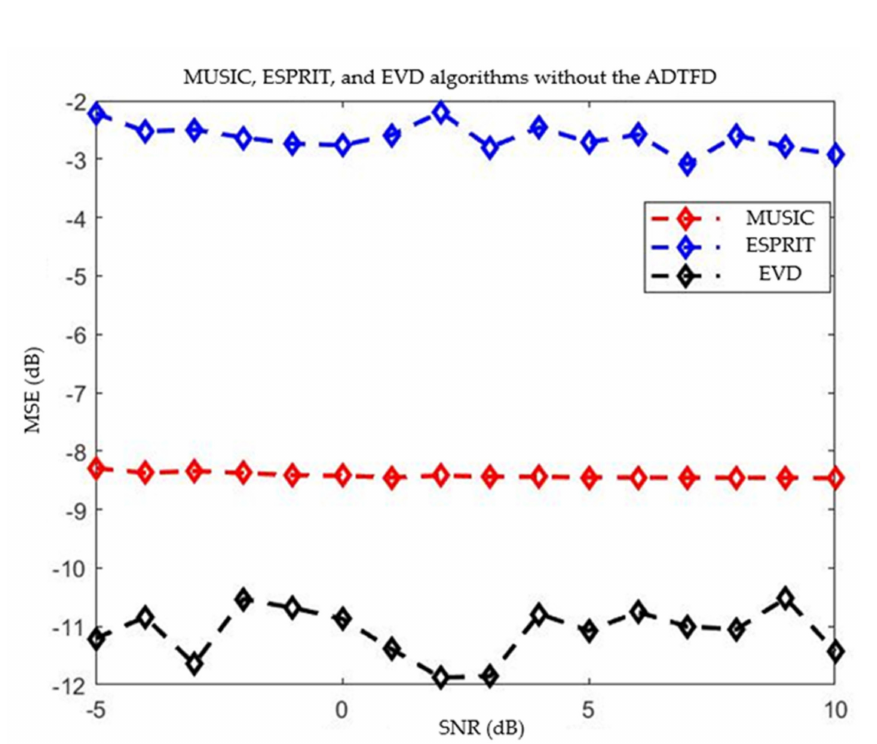
Figure 5. SNR vs. MSE plot of the MUSIC, ESPRIT, and Eigenvalue Decomposition algorithms without the ADTFD preprocessing